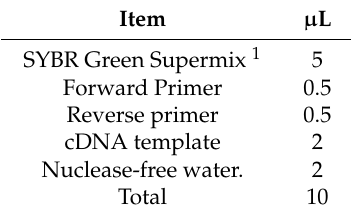
Table 3. Real time-polymerase chain reaction